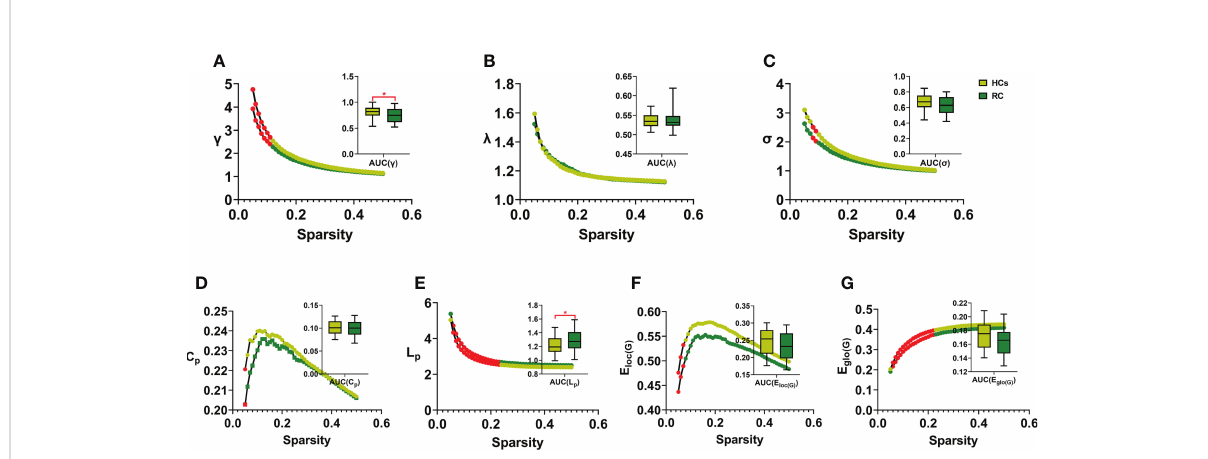
FIGURE 2 Comparison of small-world properties and network measures between groups. RC, rectal cancer; HCs, healthy controls. AUC, area under curve. g , normalized clustering coef fi cient; l , normalized characteristic path length; s , small-worldness (A-C) . C p : clustering coef fi cient of network; L p , characteristic path length of network; E loc(G) , local ef fi ciency of network; E glo(G) , global ef fi ciency of network (D-G) . Red dots and stars indicated statistical signi fi cance P < 0.05. Two sample t -tests were employed for statistical analysis and P value less than 0.05 was considered signi fi cant. * indicated statistical signi fi cance.